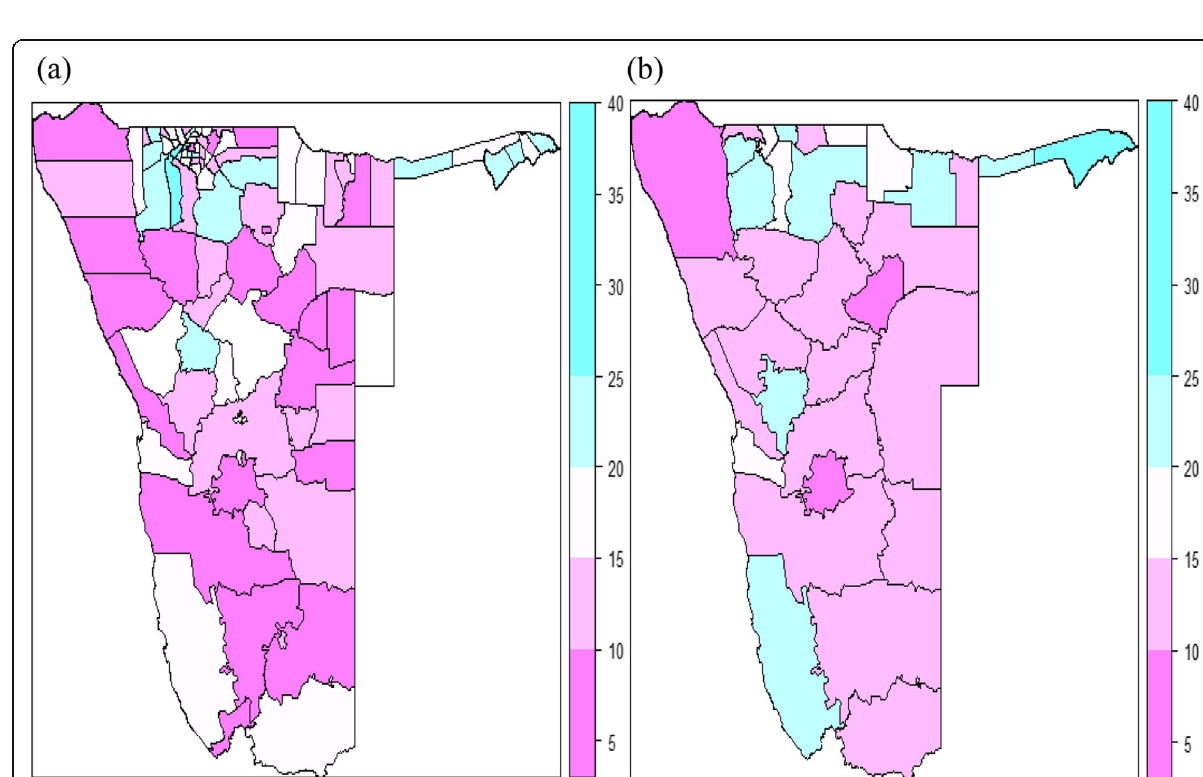
Fig. 2 Observed HIV prevalence (in %): ( a ) constituencies ’ HIV prevalence (2013 NDHS data); ( b ) health districts ’ HIV prevalence (2014 NHSS